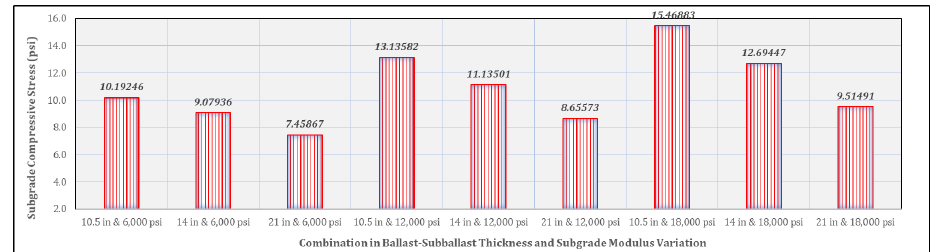
Figure 27: Influence of subgrade modulus and ballast-sub-ballast thickness on subgrade compressive stress in granular rail track.